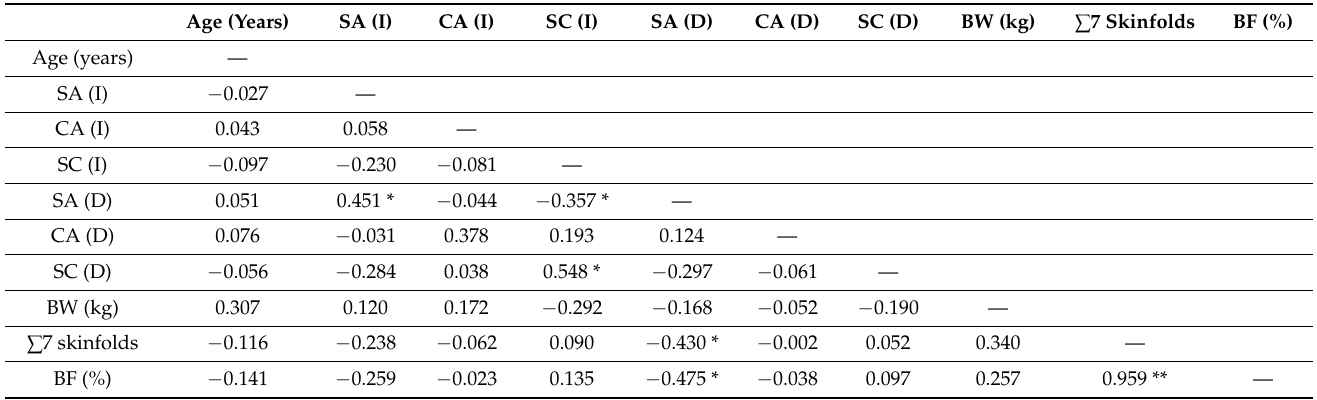
Table 3. Correlations between anxiety dimensions, age and anthropometric